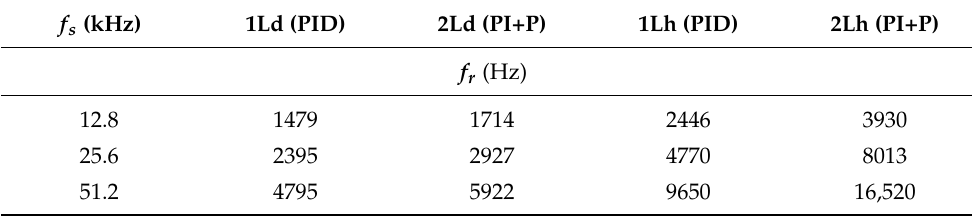
Figure 26. Frequency plots T ( ω ) of the closed-loop systems. Collections of T ( ω ) for all structures considered at various carrier frequencies f s : ( a ) 12.8 kHz; ( b ) 25.6 kHz; ( c ) 51.2 kHz. The values of f r are summarized in Table 6. f LC ≈ 700 Hz. Table 6. Resonant frequencies f r for different structures and carrier frequencies f s .